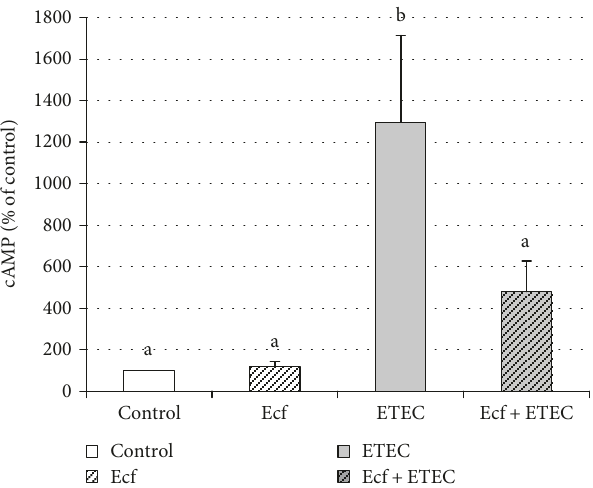
Figure 8: Intracellular cAMP concentrations in lysates of IPEC-J2 cells measured by ELISA at 4h after commencement of incubation with bacterial strains (Ecf, ETEC, and Ecf +ETEC) compared with control [means ± SEM]. Groups di ff er signi fi cantly ( P ≤ 0 05 ) when marked with di ff erent letters, (e.g., a, b) in the fi gure. N = 5 independent